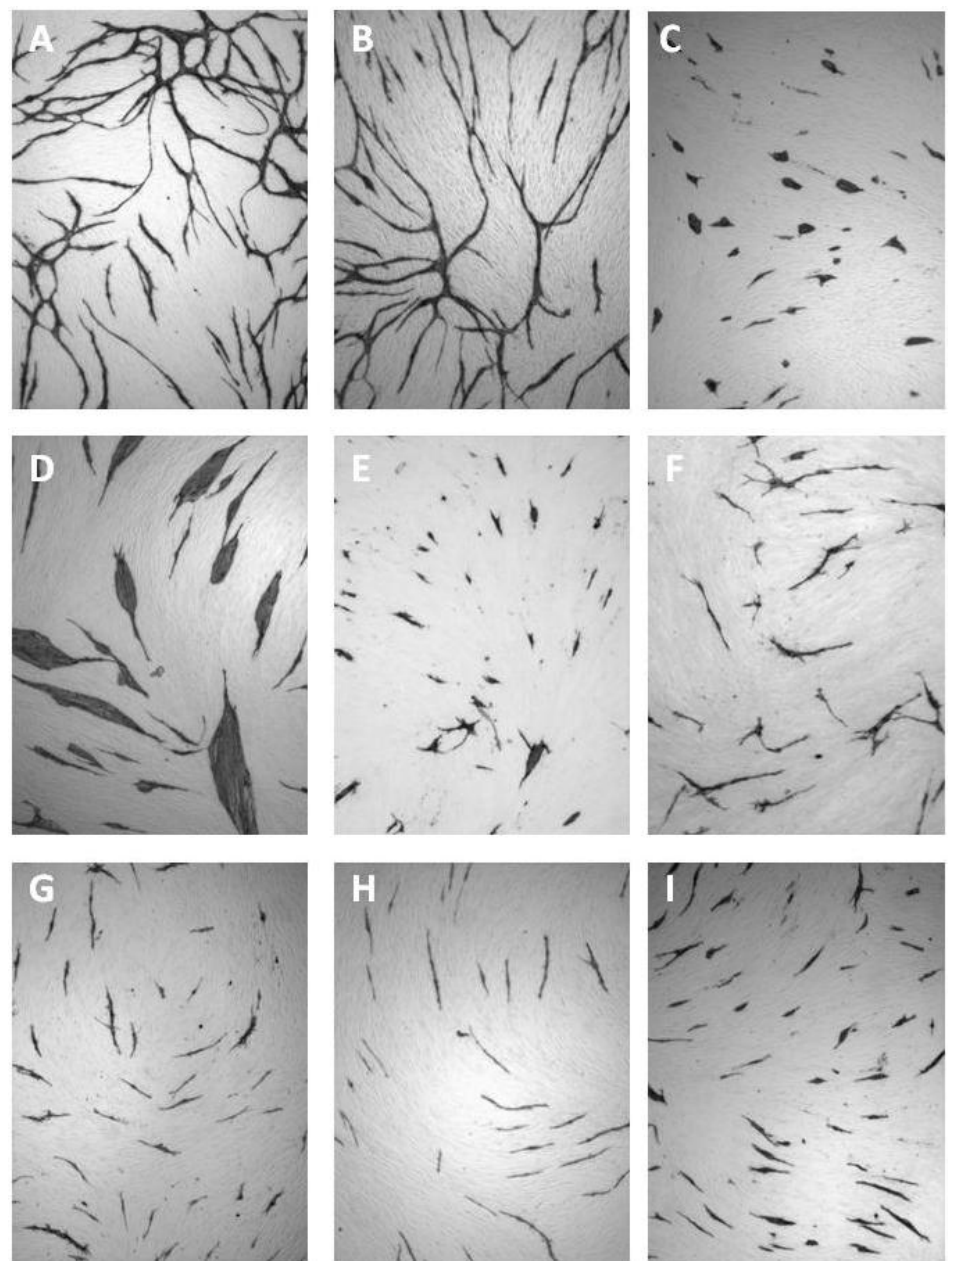
Figure 5. Effect of angiogenesis inhibitors in the coculture assay. HUVECs propagated in coculture with fibroblasts in TFSM2 medium ( A ) or TFSM2 medium with: ( B ) PBS, ( C